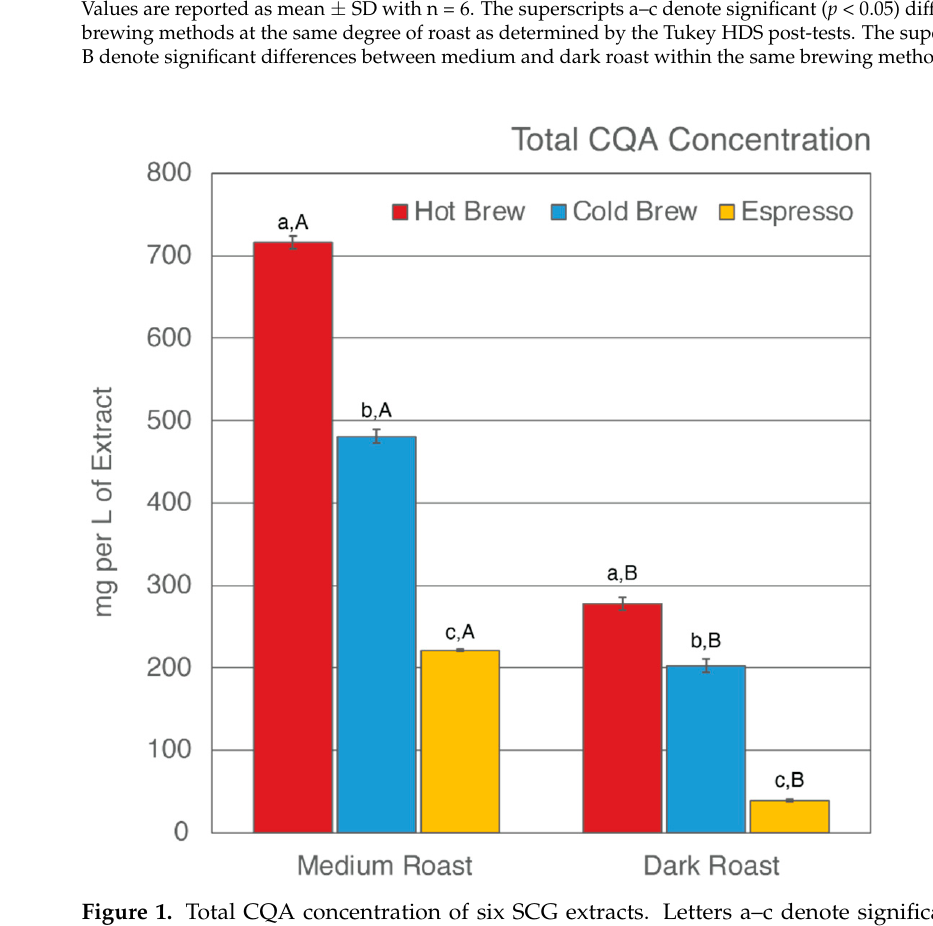
Figure 1. Total CQA concentration of six SCG extracts. Letters a–c denote significant ( p < 0.05) differences among brewing methods at the same degree of roast as determined by the Tukey HDS post-tests. Letters A and B denote significant differences between medium and dark roast within the same brewing method.